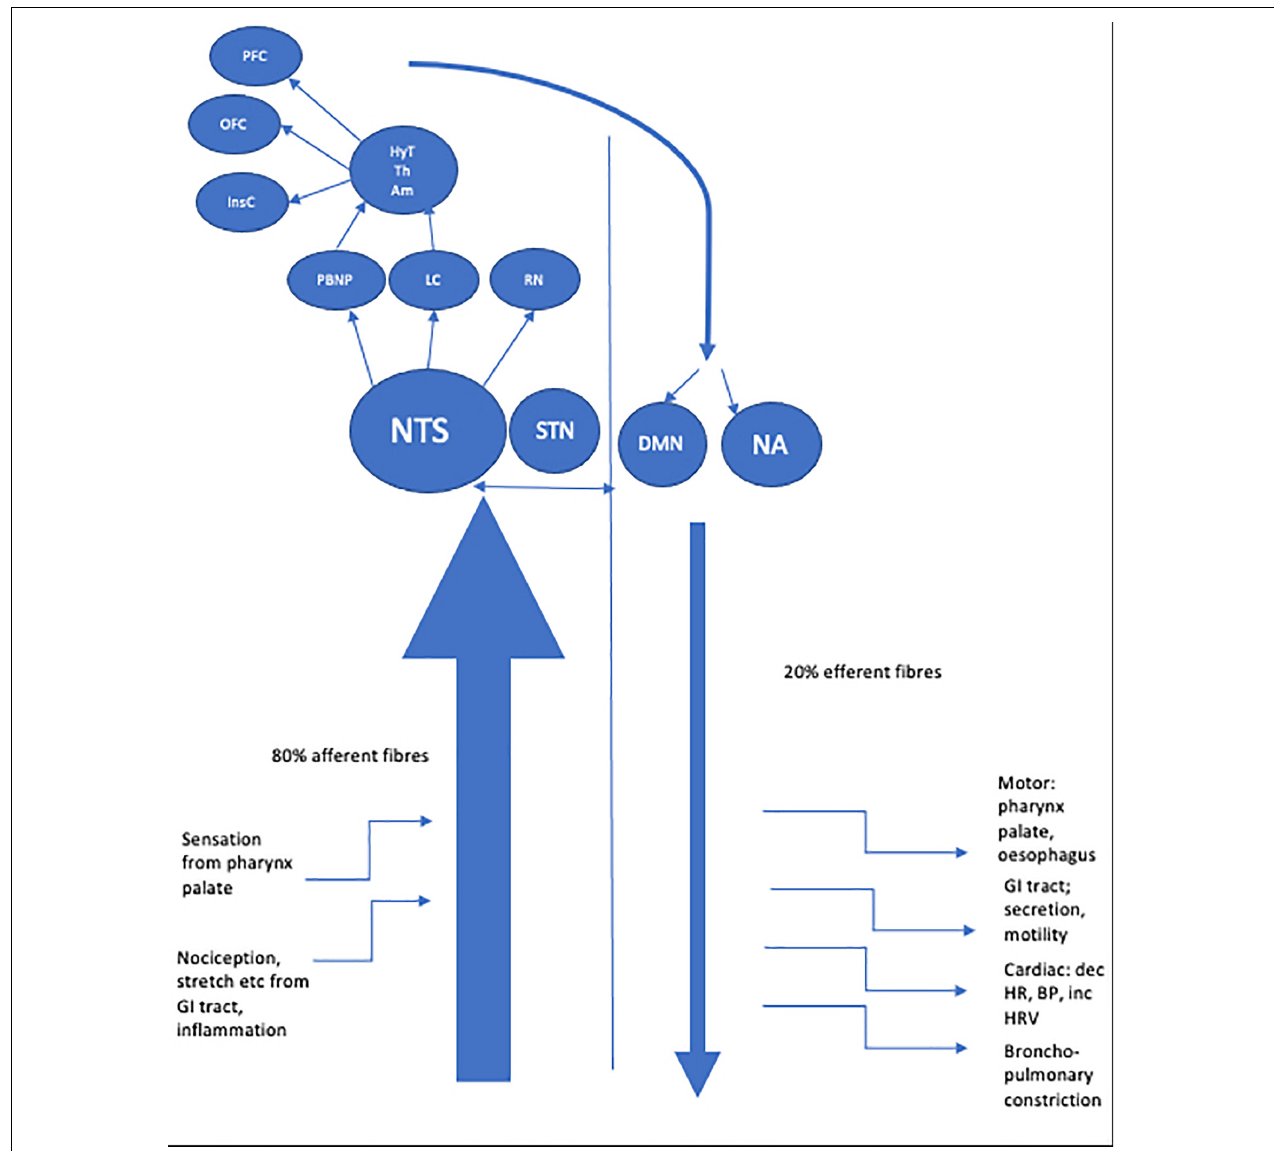
FIGURE 1 | Schematic representation of afferent and efferent fibers of the vagus nerve and central